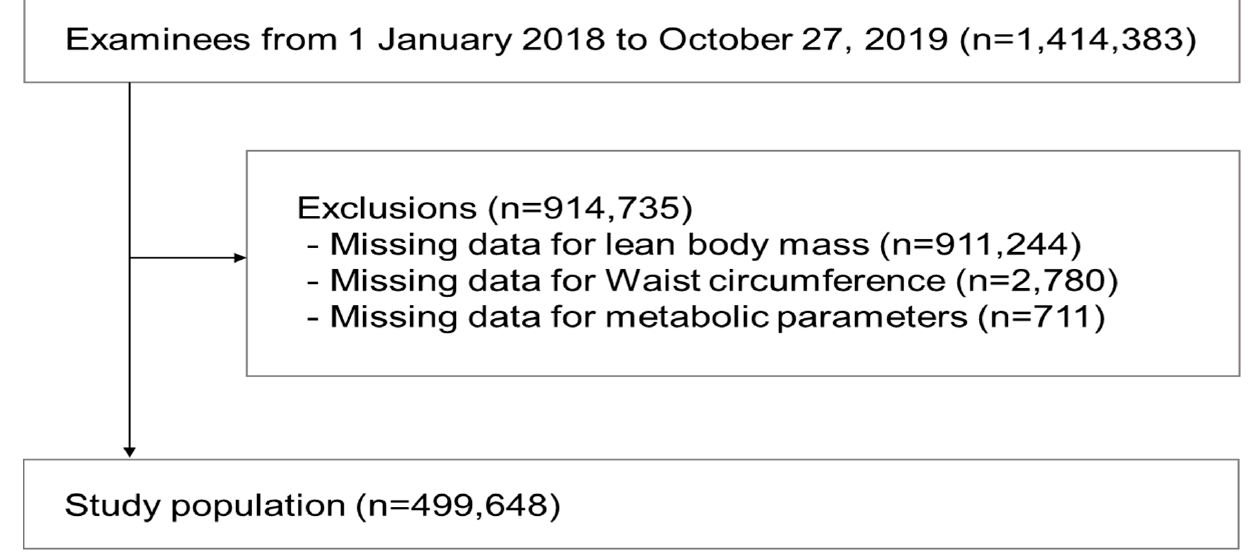
Figure 1. Study flow chart.